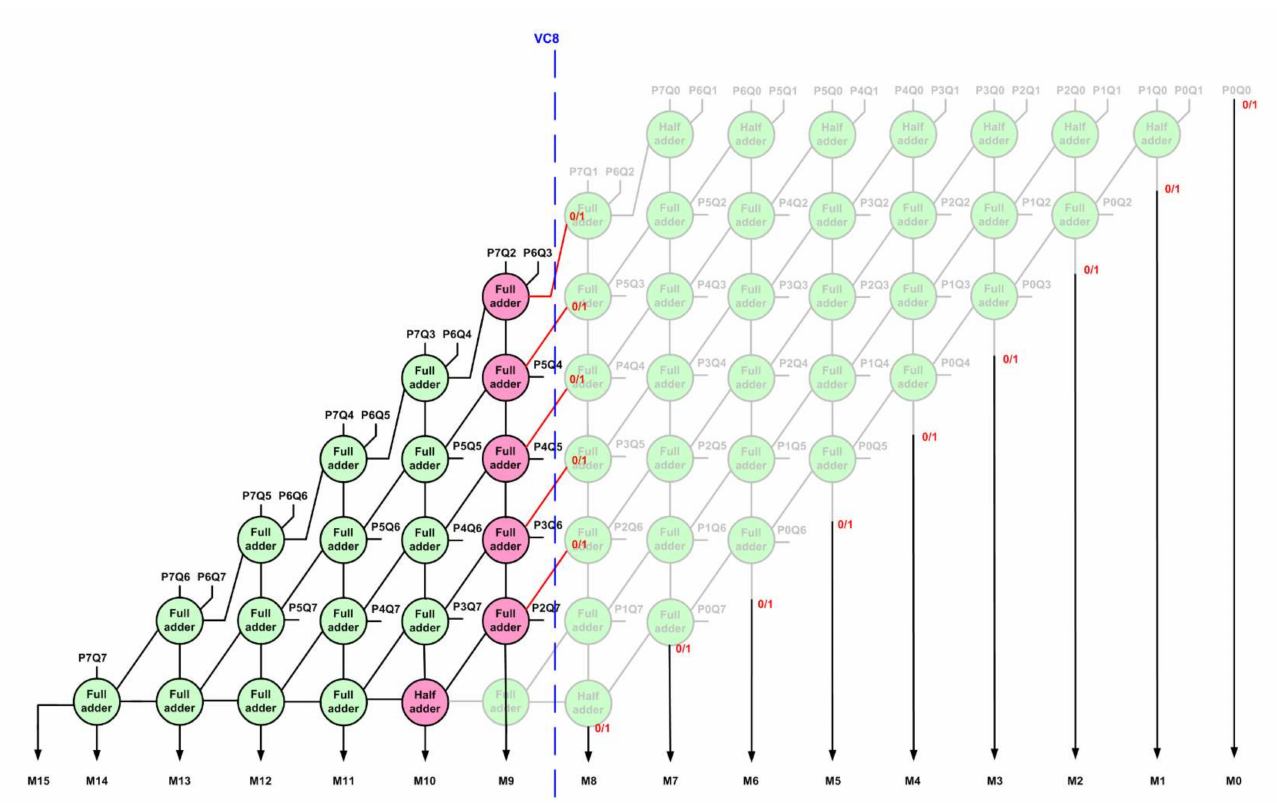
Figure 2. Portrayal of how IAMs are derived by making an example vertical cut VC8 on an 8 × 8